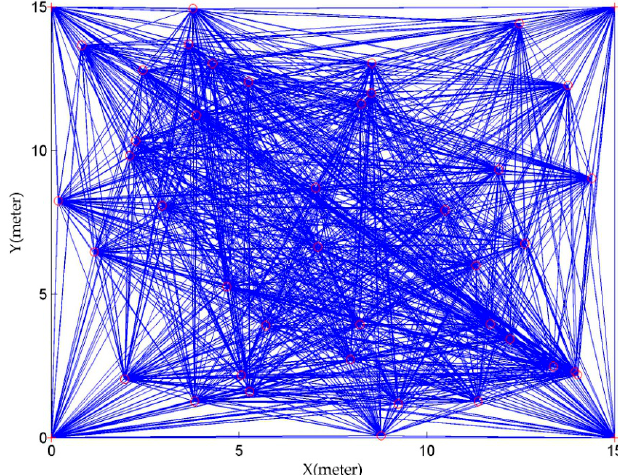
Figure 9. Network topology of sensor nodes, the ( ◦ ) represents unknown nodes, the ( + ) represents anchor nodes and the ( − ) represents the communication connectivity between sensor nodes.